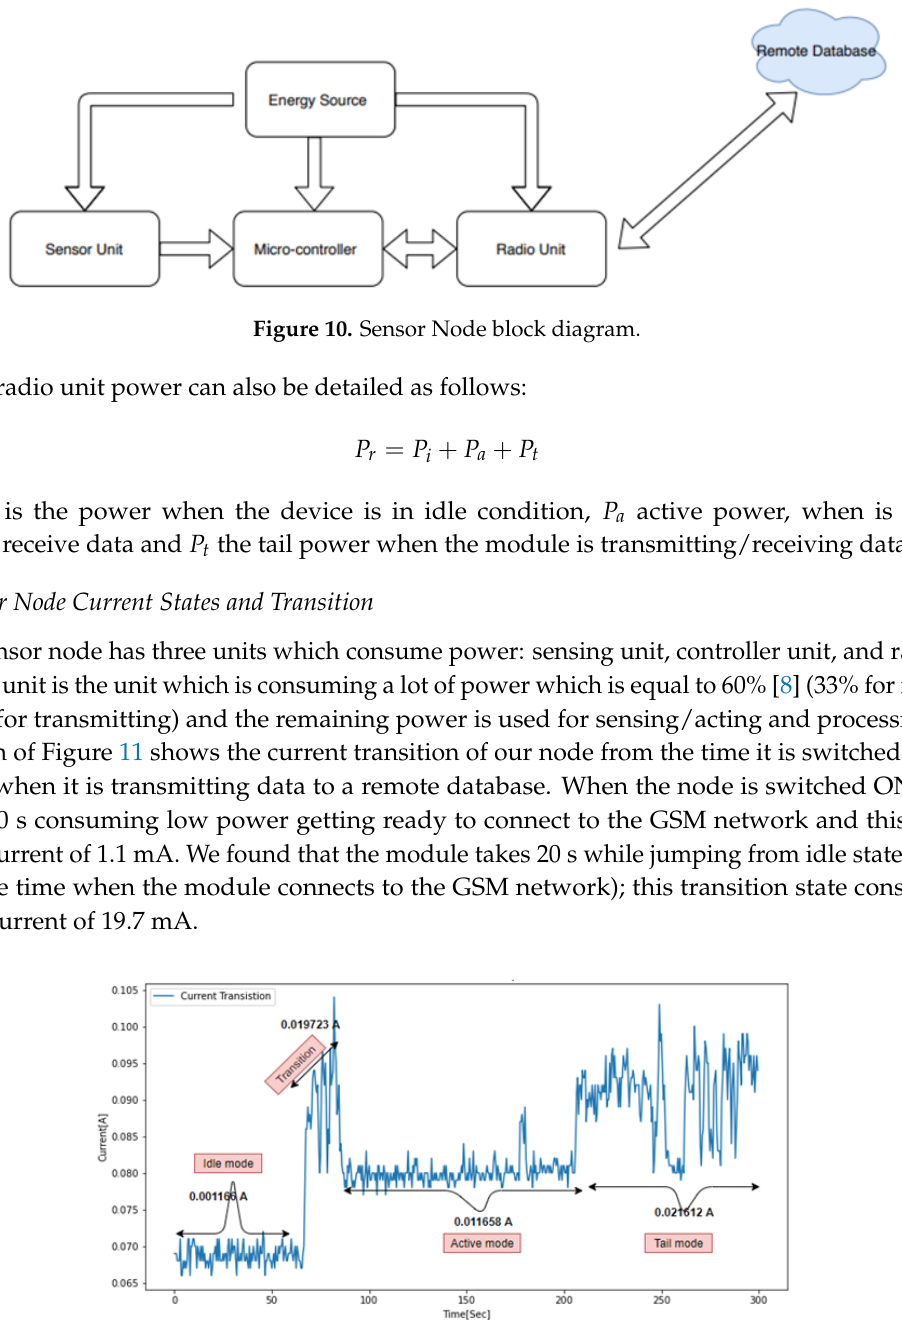
Figure 11. Current transition